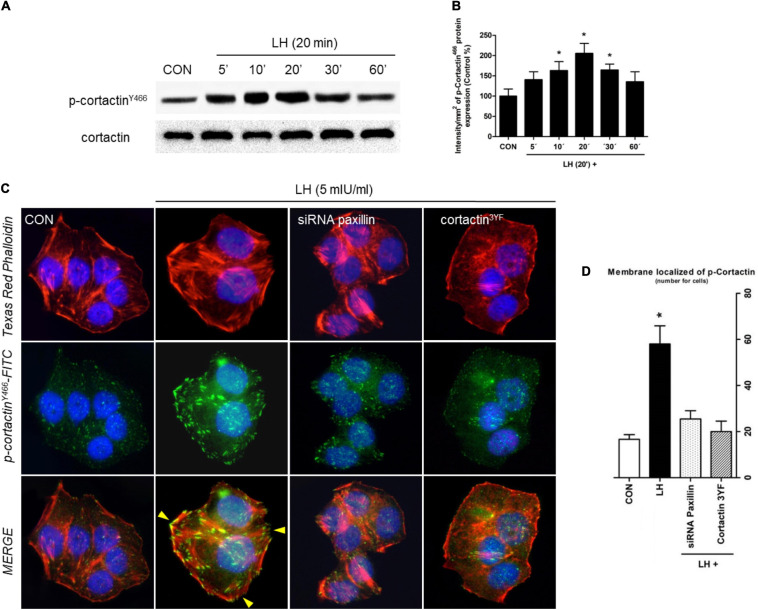
LH induces dynamic actin remodeling in BC cells. (A) BC cells were treated for different times (0–60 min) with LH (5 mIU/ml). The total cell amounts of wild-type cortactin and phosphorylated cortactin (cortactinY466) are shown by western blot analysis. (B) Phospho-cortactinY466 densitometry values were adjusted to cortactin intensity and then normalized to the control sample. *P < 0.05 vs. control. (C) T-47D cells were treated with LH for 20 min in the presence or absence of a siRNA paxillin or cortactin3YF construct. Cells were stained with phospho-cortactinY466 linked to FITC, actin was stained with phalloidin linked to Texas Red, and nuclei were counterstained with DAPI. Yellow arrows indicate membrane-localized p-cortactinY466. (D) Quantification of the membrane-localized p-cortactin in the different conditions. Results are expressed as dots/cells (mean ± SD). *P < 0.05 vs. CON, control. Membrane-localized p-cortactinY466 was counted in 40 different cells. All experiments were performed in triplicate, and representative images are shown.